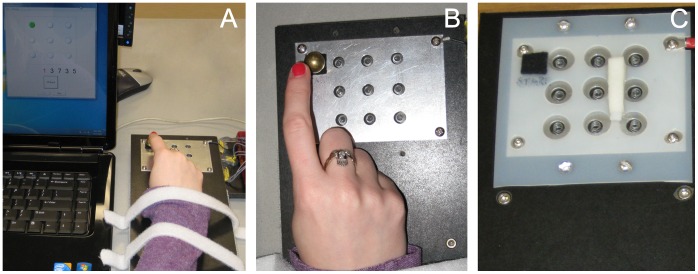
The Marble Navigation Task used to measure skilled motor learning.(A) Participants view the computer screen to see where to move the marble. (B) The MNT board used for week 1. (C) A novel version of the same MNT board was used for week 2.